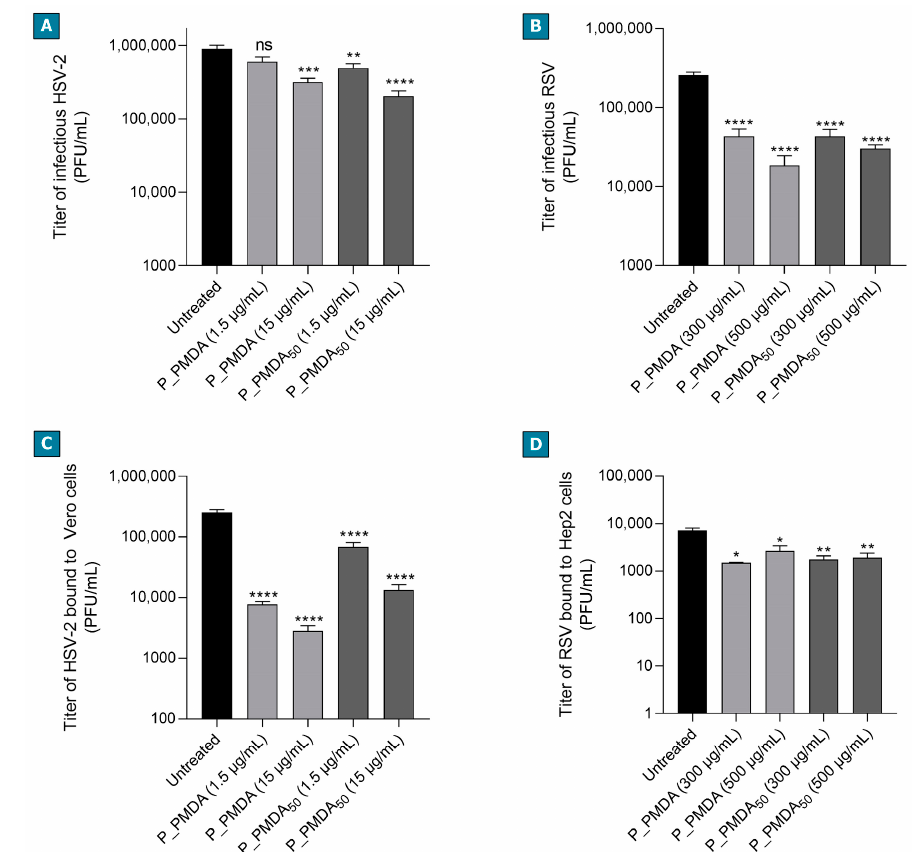
Table 2. Antiviral activity of β CD-based polymers against RSV, HSV-2, FluVA, and HRoV. * EC 50 (µg/mL) Polymer